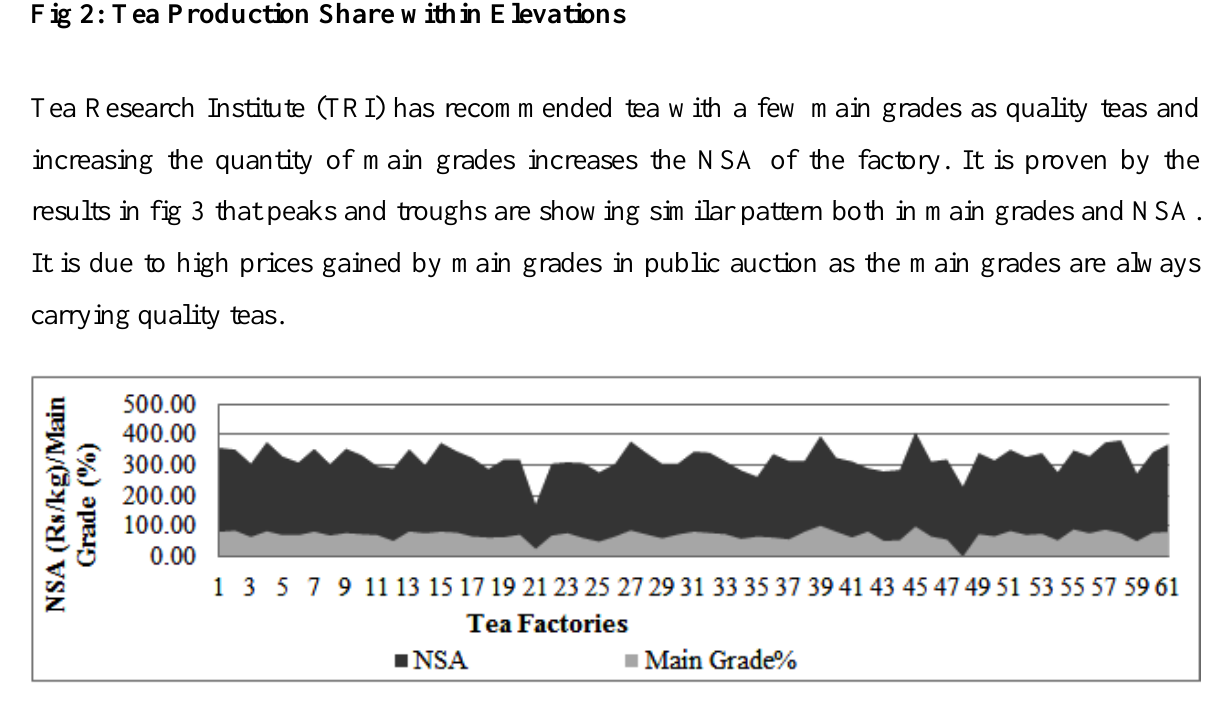
Fig 2: Tea Production Share within Elevations